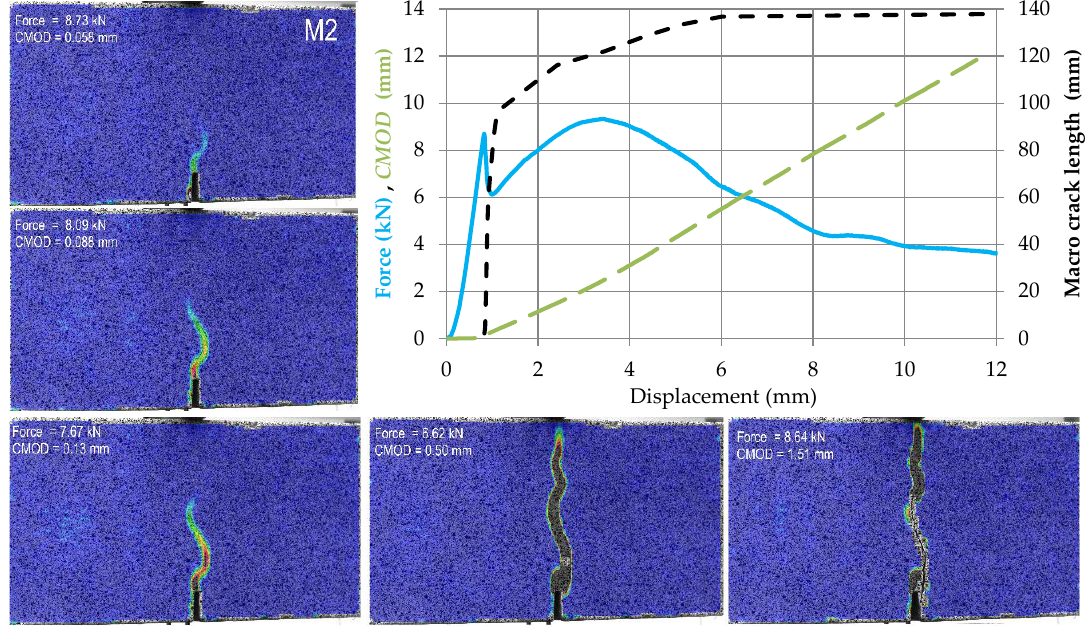
Figure 11. Force, CMOD and summary macrocrack length as a function of displacement in case of material M2 accompanied by cracks development in five chosen stages (contour plots of equivalent Huber–Mises strains).